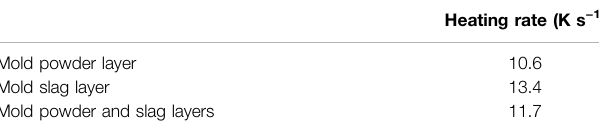
TABLE 3 | HRs in the mold powder/slag layers on top of the steel meniscus in the